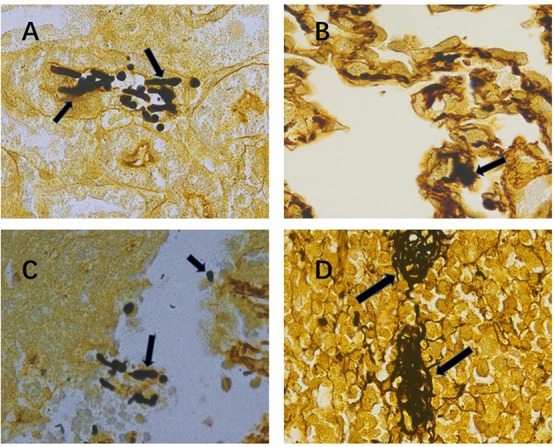
Confirmation of severe invasive Candida albicans multiorgan infection mouse model. Representative kidney (A), lung (B), liver (C) and spleen (D) histological sections at 12 h after intravenous injection of C. albicans were stained with Gomori’s methenamine silver to visualize C. albicans hyphae and spores. Black arrows indicate hyphae and spores. Magnification, 1000×.